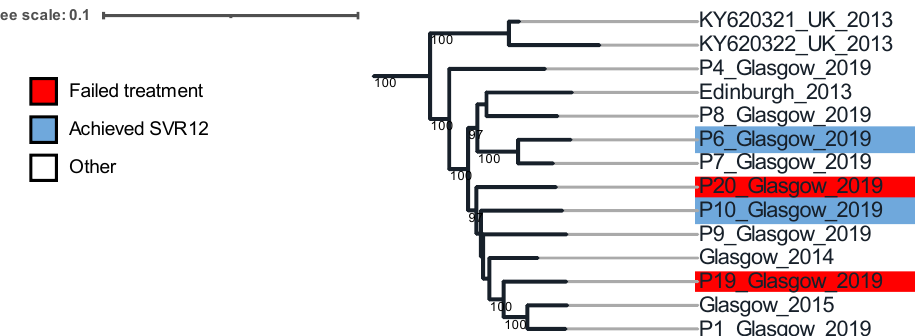
Figure 1. Maximum likelihood tree of whole nucleotide HCV genomes constructed with 1000 bootstrap replicates. This tree shows the Glasgow subtype 2a phylogenetic cluster that includes treatment failures P19 and P20, and P6 and P10 who were both successfully treated. Non-highlighted tree branches represent other sequences, from Scotland, in this 2a cluster, and two HCV sequences downloaded from GenBank [18], also from UK.